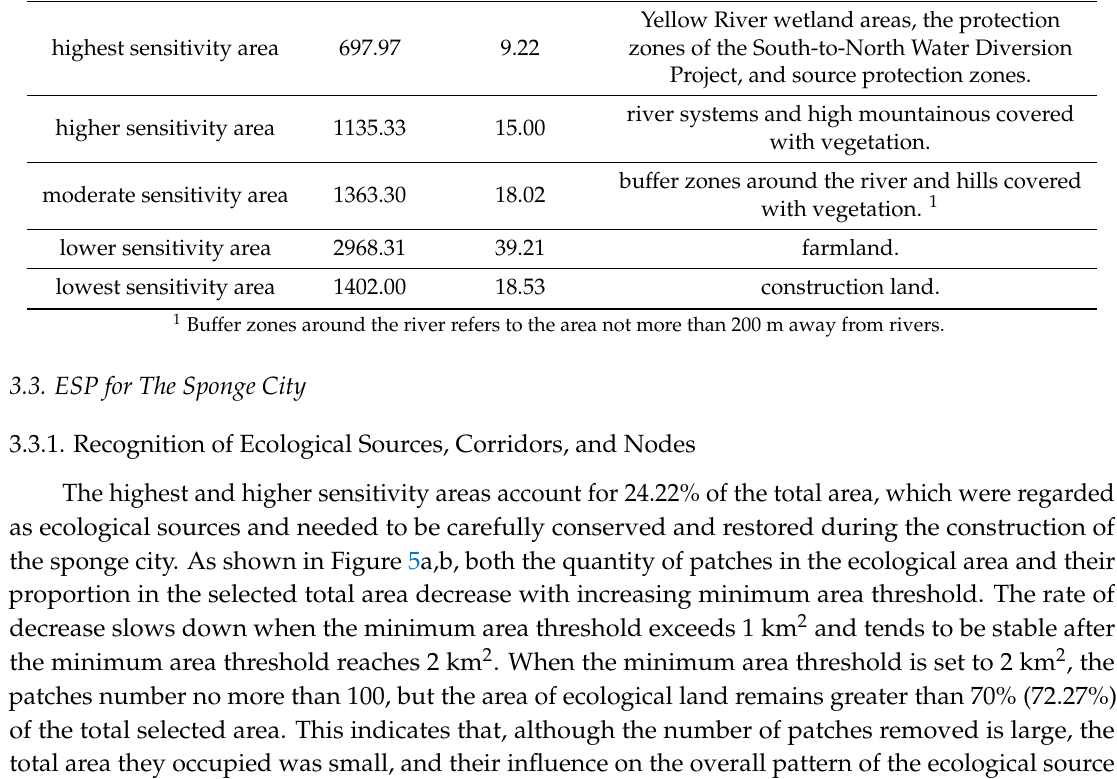
Table 4. Resistance values of the resistance surface in Zhengzhou. Ranks of Ecological Sensitivity